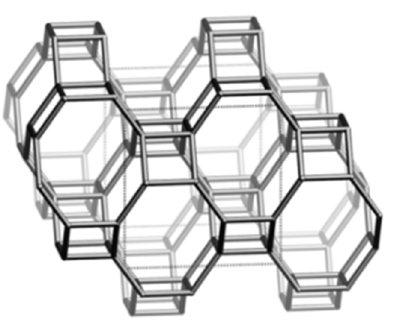
https://asia.iza-structure.org/IZA-SC/ftc_table.php. (accessed on 23 June 2022). //asia.iza-structure.org/IZA-SC/ftc_table.php. (accessed on 23 June